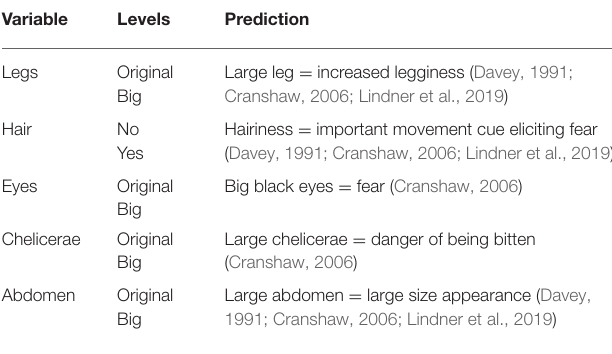
TABLE 1 | Aesthetic characteristics manipulated for five spider “types.” Variable Levels